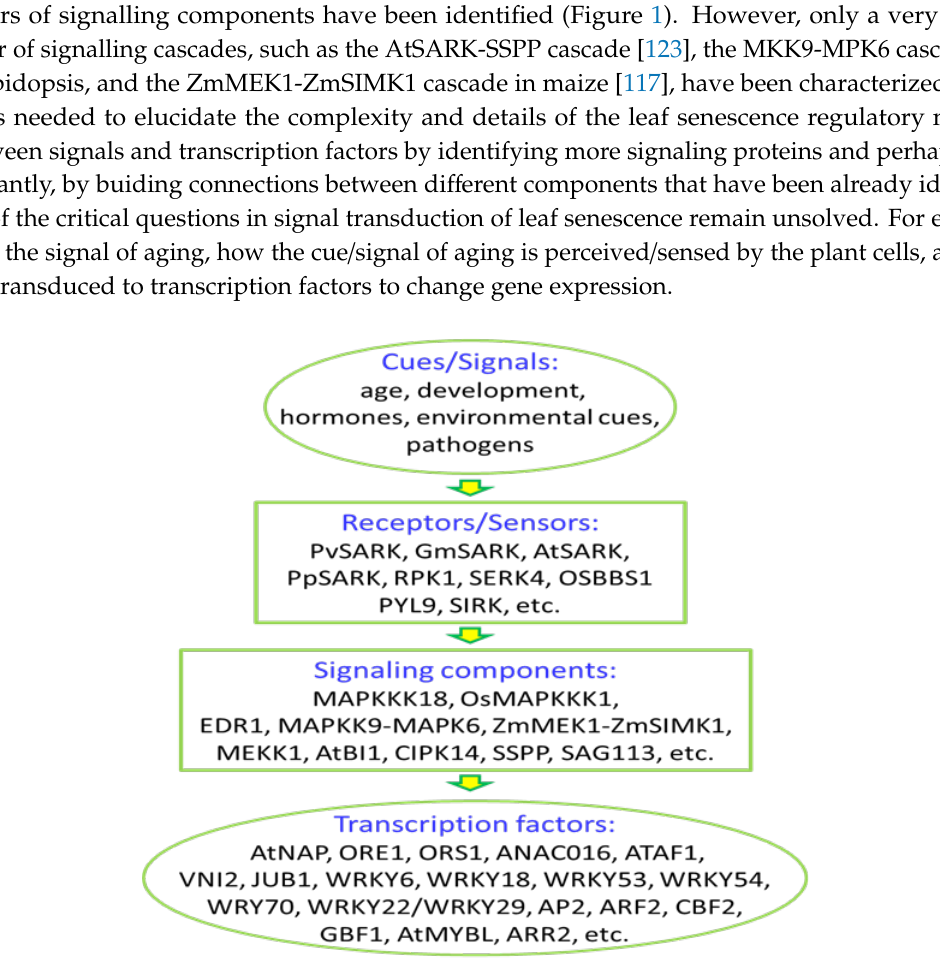
Figure 1. Signaling components identified in the process of leaf senescence.